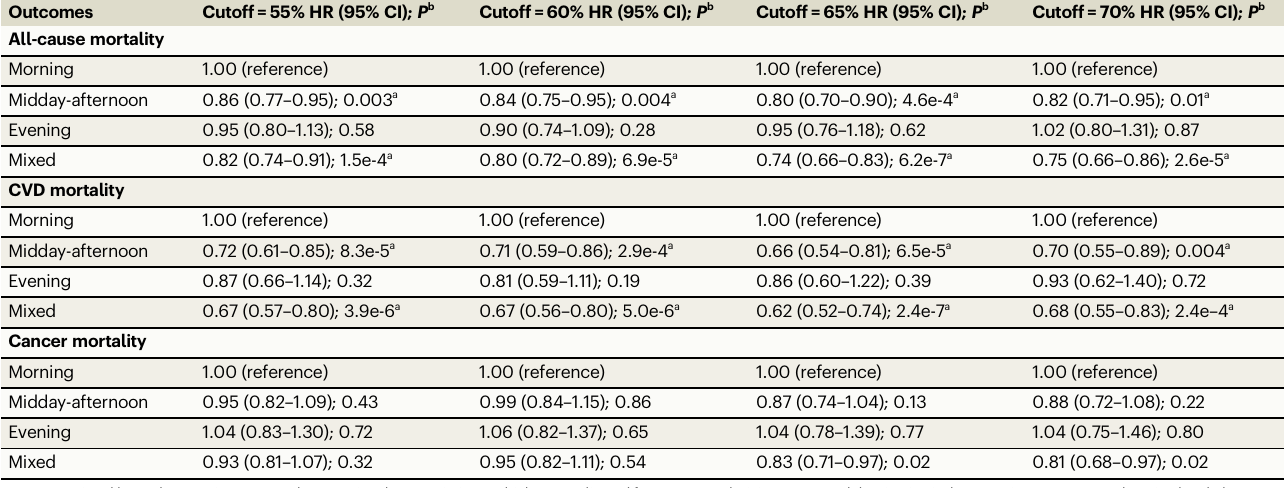
Table 3| Sensitivity analysis on the associations between timing of MVPA and mortality risk byusing different cutoffsfor timing group assignment a